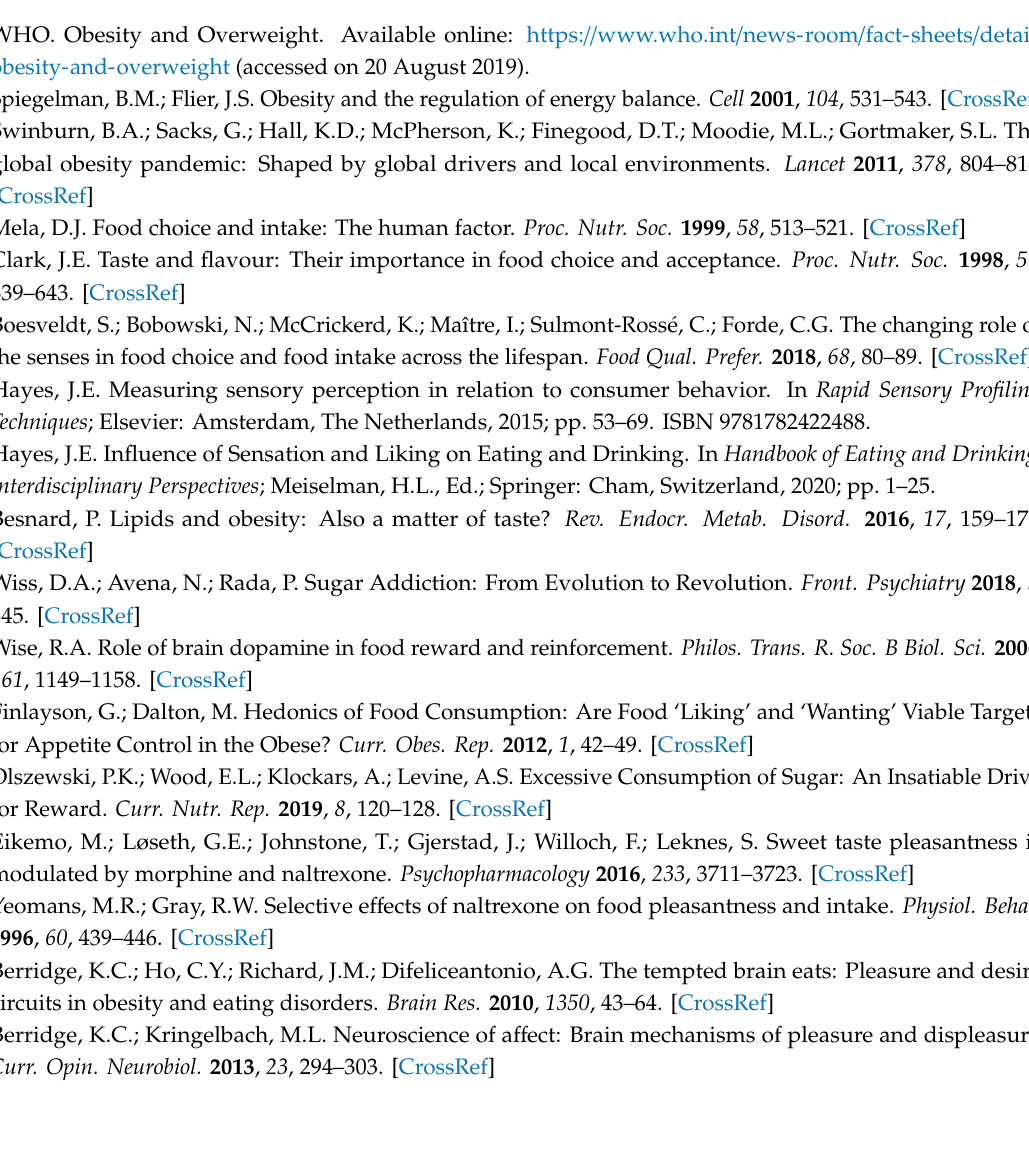
Anthropometric characteristics by country; Table S4: Interaction e ff ects of age on phenotypic di ff erences in anthropometric